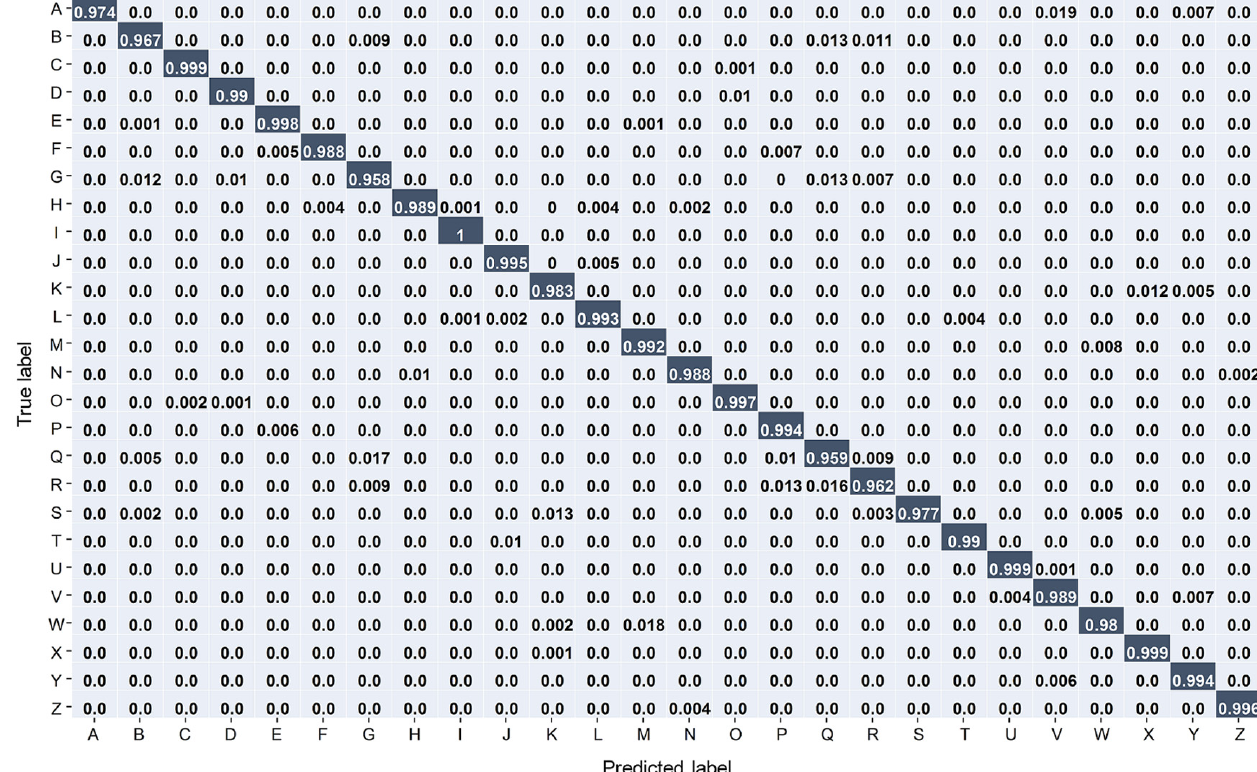
Figure 9. Confusion matrix of MoAS-CNN on 32 × 32 dataset.